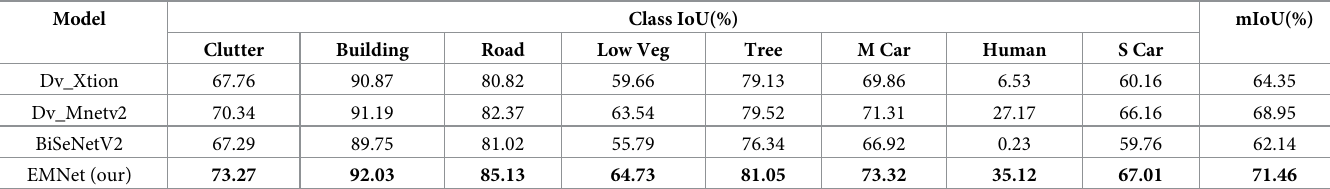
Table 4. mIoU values for each model for different categories on the UAVid test set. Model Clutter